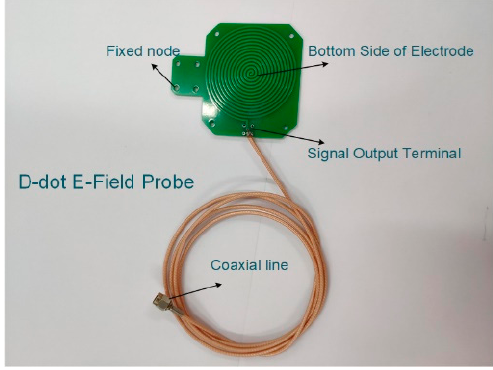
Figure 1. D-dot E-field sensor with parallel distributed electrode.